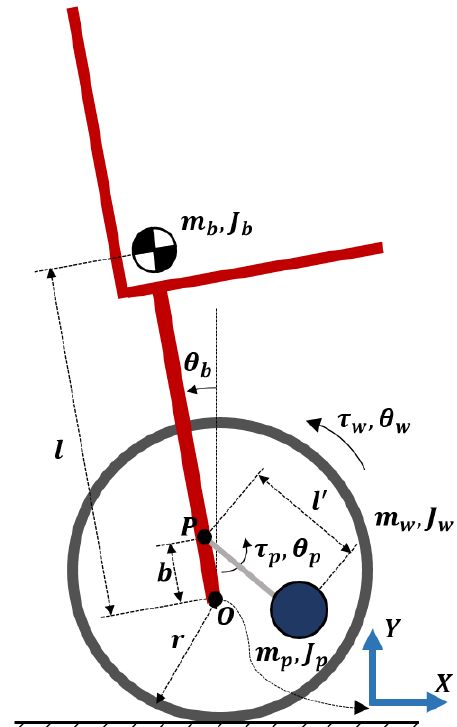
Figure 1. Two-wheeled wheelchair and proposed